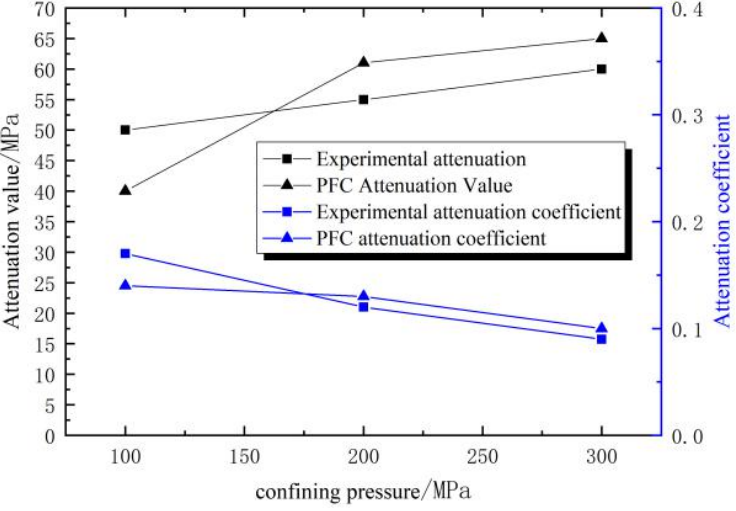
Figure 8. Comparison between the attenuation value and attenuation coefficient of the coal gangue.